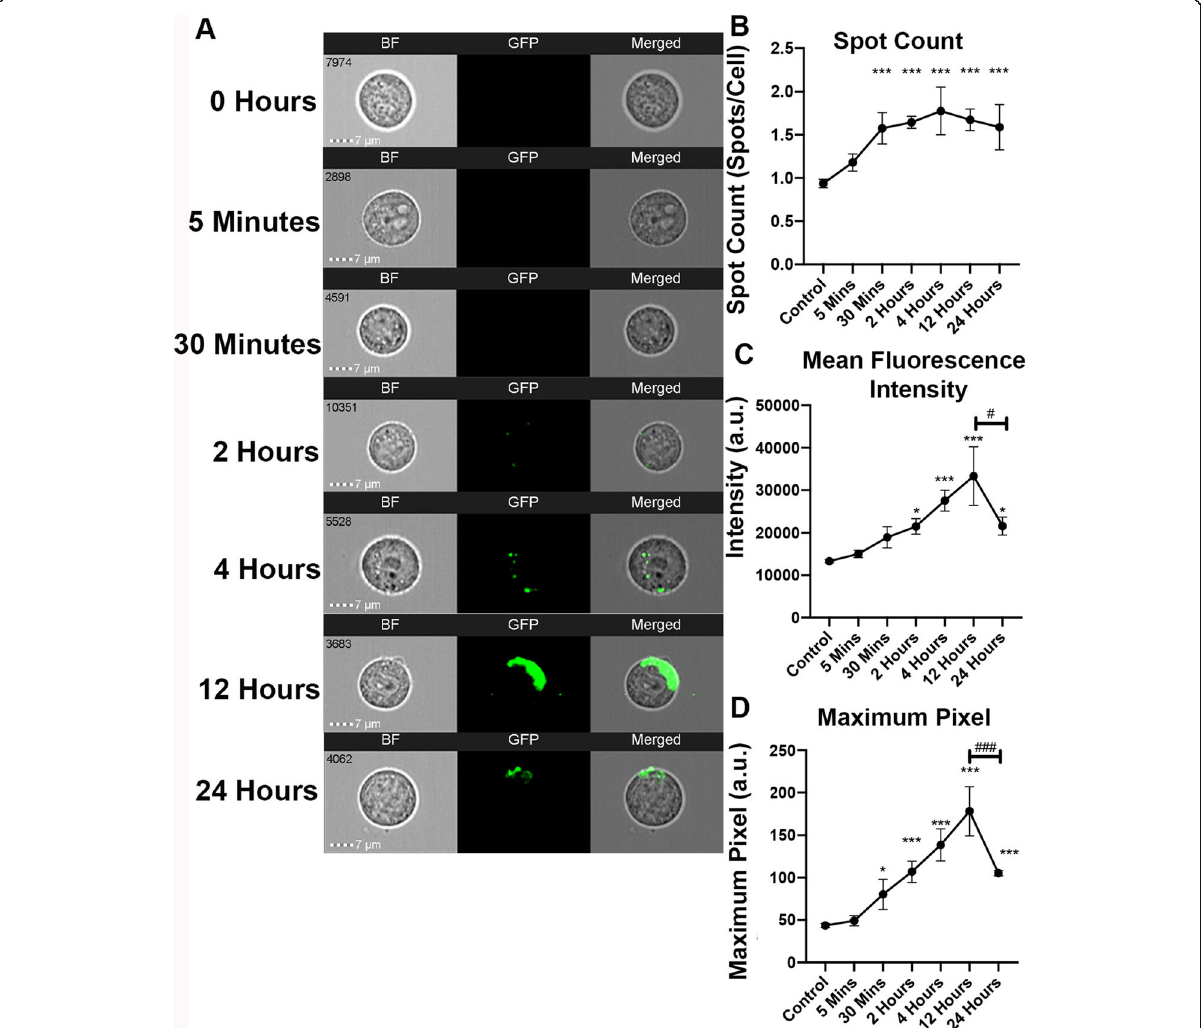
Fig. 4 HEK293T EV uptake is time dependent. HEK293T cells were co-cultured with 6000 HEK293T EVs/cell for increasing lengths of time. a Representative IFC images of recipient cells, respectively. GFP localization signifies increased HEK293T EV uptake. b – d Quantification of time course assays compared with controls and each group via spot count, mean fluorescence intensity, and maximum pixel ratios. Bars represent mean ± SEM; N = 3; one-way ANOVA followed with Tukey ’ s post hoc test. * p < 0.05; *** p <